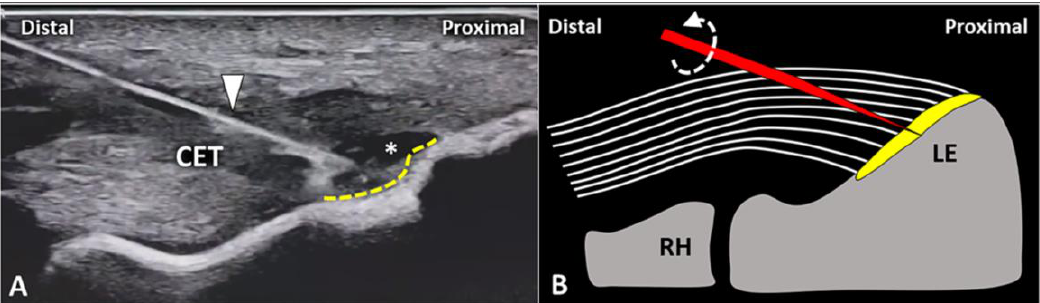
Figure 6. In a patient with focal avulsion of deep fibers of CET from the lateral epicondyle ( LE ), a two-step USG procedure can be performed. Using an in-plane distal-to-proximal approach, the needle ( white arrowhead ) is advanced within the injury ( white asterisk ) and local anesthetic is injected to “uncover” the underlying enthesis ( yellow dotted line ) ( A ). Schematic drawing shows multiple rotations ( curved dotted arrow ) of the needle’s tip ( red ) for mechanical drilling of the fibrocartilage ( yellow ) to induce a local micro-bleeding ( B ). RH: radial head.